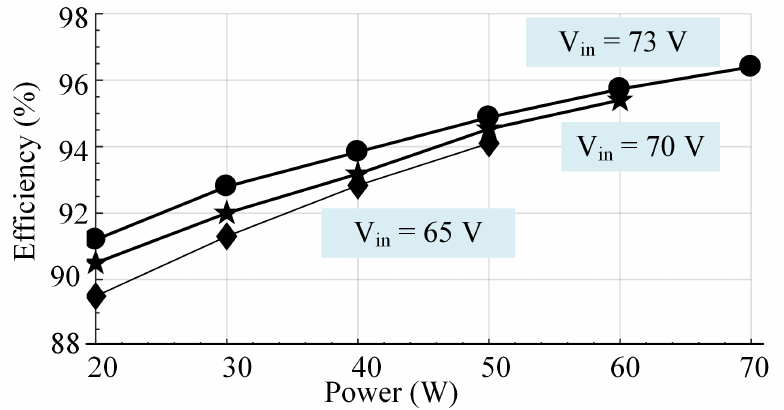
Figure 23. Efficiency curve of the proposed inverter.